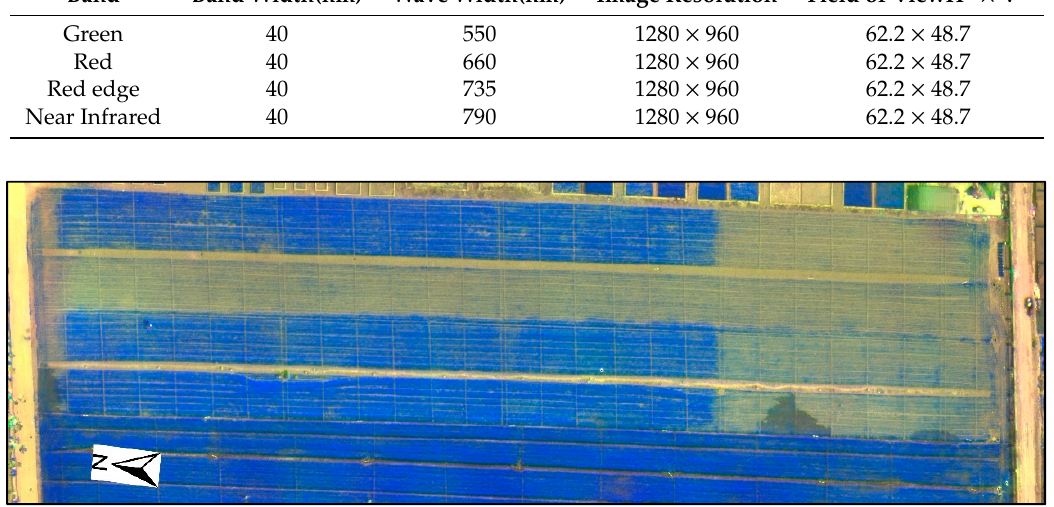
Figure 2. Pseudo color multispectral image of the experimental area on 4 April 2019 (Red-Green-Near Infrared).